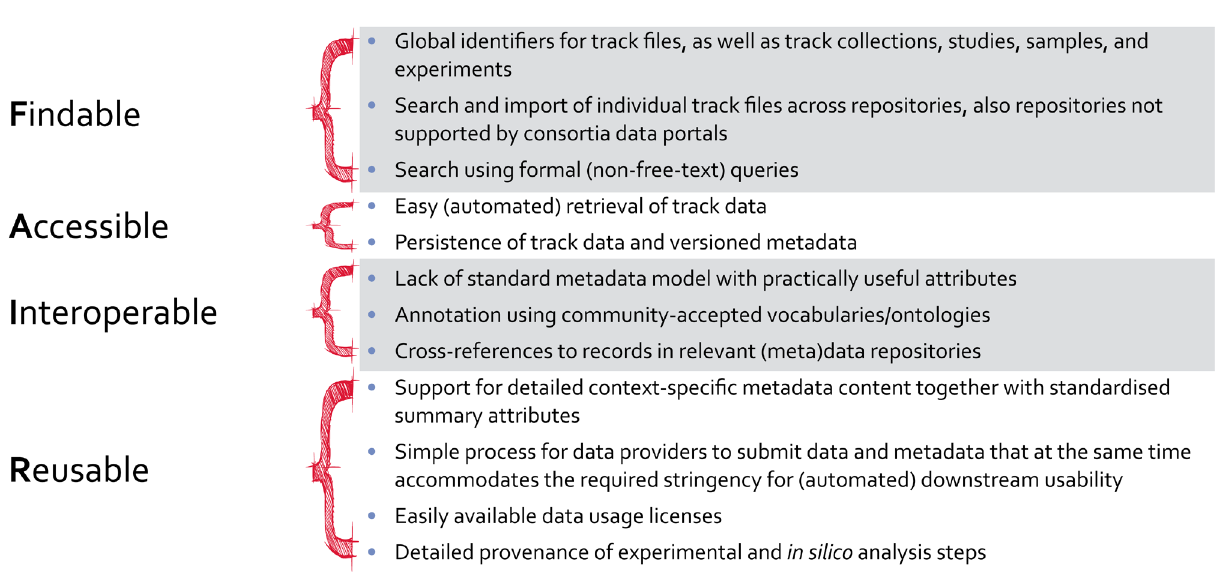
Figure 2. Important topics where the current state of track data and metadata have potential for improvements, as mapped to the FAIR 5